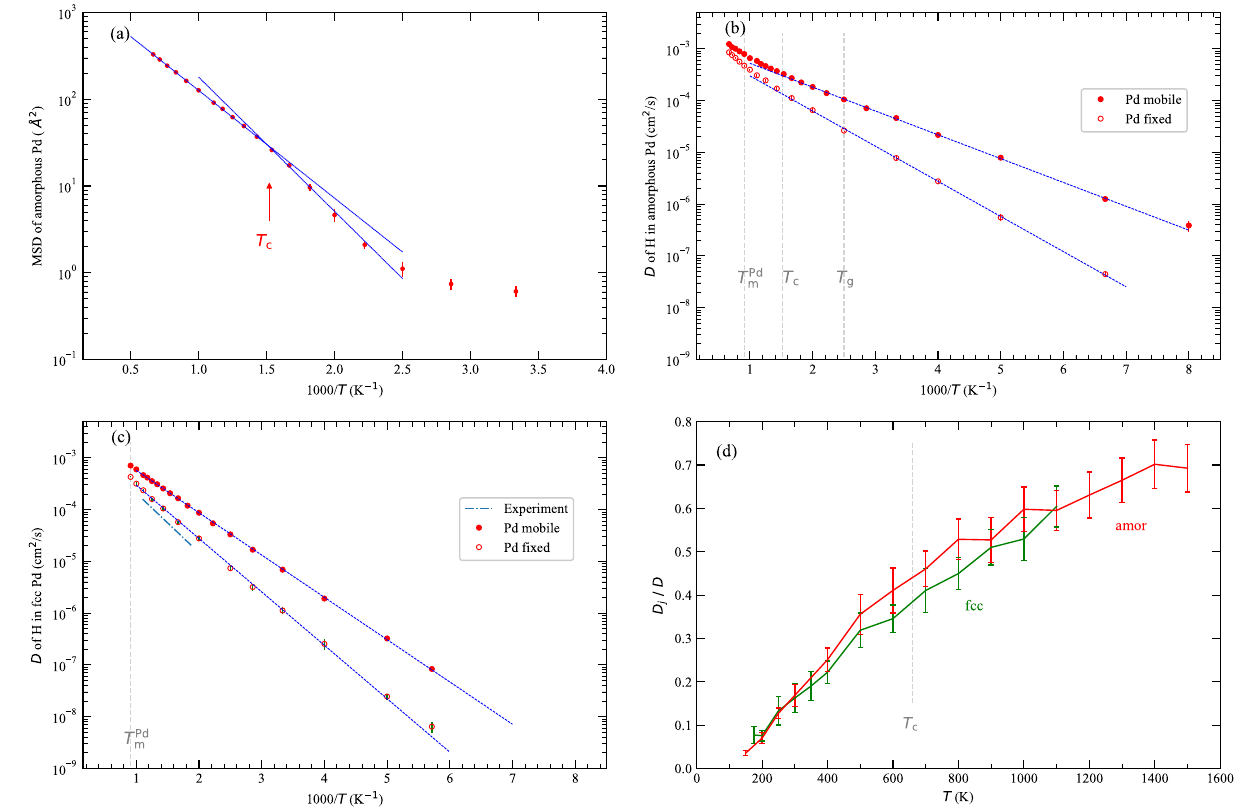
Figure 1. Diffusion of H in Pd matrix, with Pd fixed and not fixed, respectively. ( a ) MSD of amorphous Pd atoms with respect to temperature at a given sampling time t = 100 ps. T c ( ∼ 660 K) is the estimated mode coupling temperature for Pd diffusion. ( b ) Hydrogen diffusion in amorphous Pd. The Arrhenius fitting gives D 0 3 3 2 = 1.52 × 10 − and E a = 0.091 (in cm /s and eV, same for below), and D 0 = 1.43 × 10 − and E a = 0.13 for Pd fixed. T g ( ∼ 400 K) is the estimated glass transition temperature, and T m ( ∼ 1100 K) is the melting point of fcc Pd. ( c ) 3 3 Hydrogen diffusion in fcc Pd. The Arrhenius fitting gives D 0 = 3.76 × 10 − and E a = 0.16 , and D 0 = 3.20 × 10 − and E a = 0.20 if Pd is fixed. The experimental diffusion data are from reference 18 . ( d ) The ratio of H diffusion coefficient in fixed Pd ( D j ) to that in mobile Pd ( D ). The errorbars are for standard deviation of 10 independent simulations (same for other figures unless otherwise specified). The data for H diffusion are in Supplementary